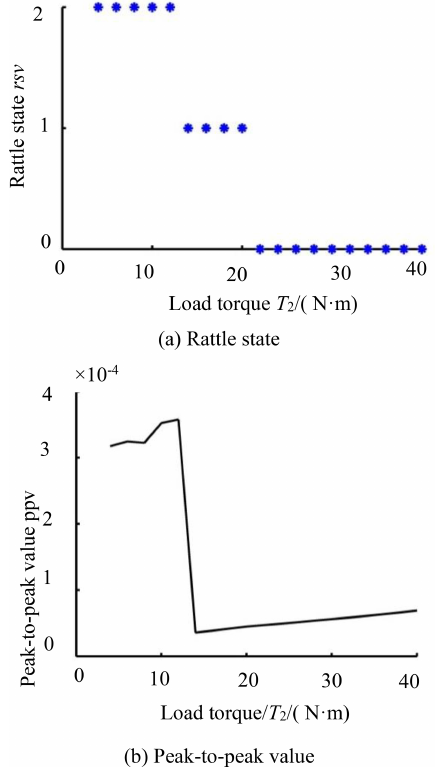
Figure 14. Change in vibration with the amplitude coefficient of meshing stiffness at different input velocities.